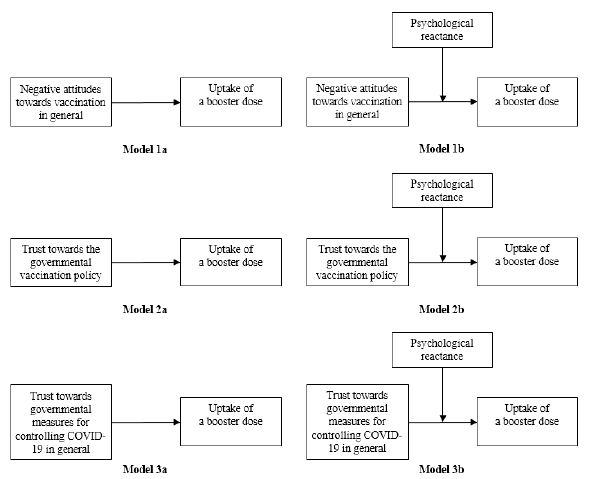
Figure 1. The hypothesized path for each of the hierarchical model. Table 4. Hierarchical regression analysis predicting uptake of a booster dose ( n = 264).